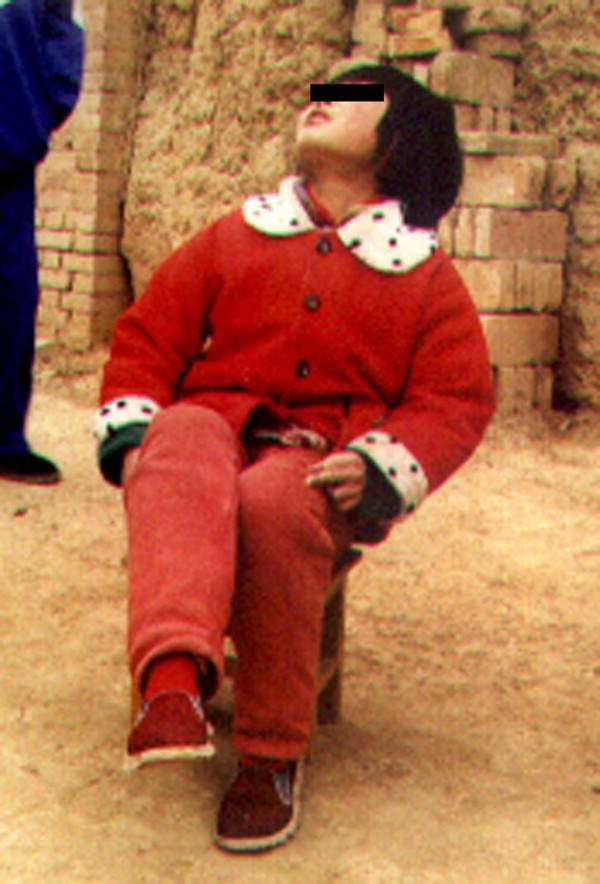
This figure shows the functional view of a level I patient; she cannot cross her legs only.